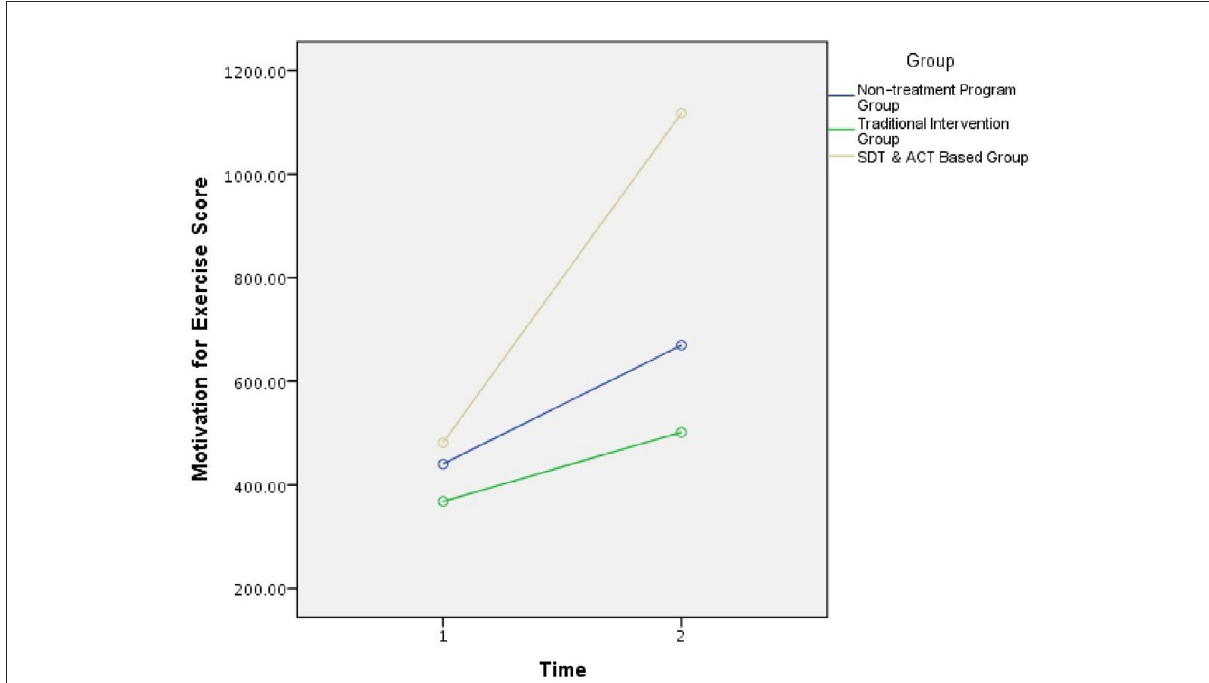
FIGURE1 The Self-Determination Theory (SDT) continuum. At one end of the self-determination continuum stands amotivation, at the middle, there are four types of extrinsic motivation, and intrinsic motivation stands on the right at the most self-determined feature of motivation. Autonomy, relatedness, and competence express the basic needs for internal